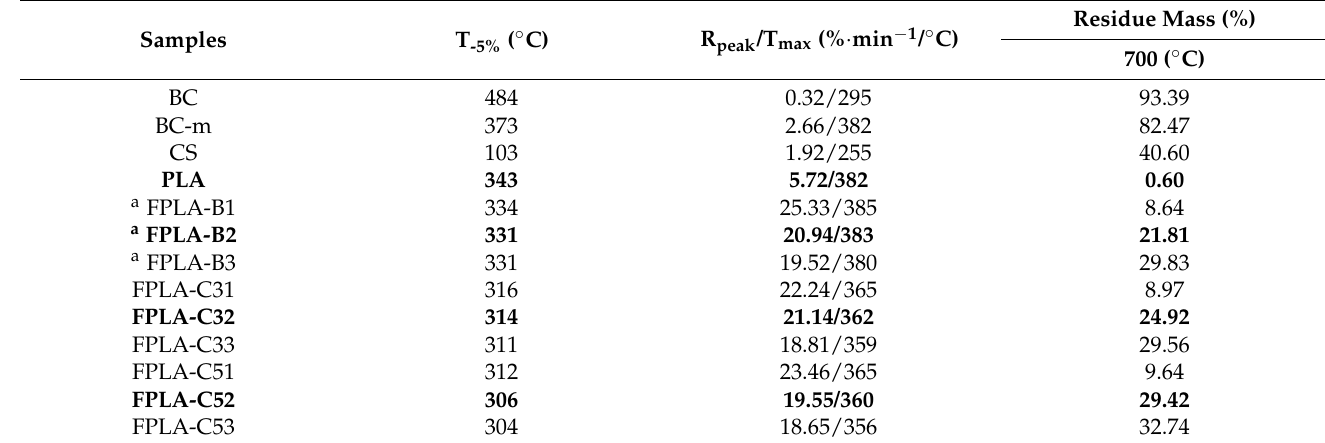
Table 4. TGA data of PLA and FPLA composites in N 2